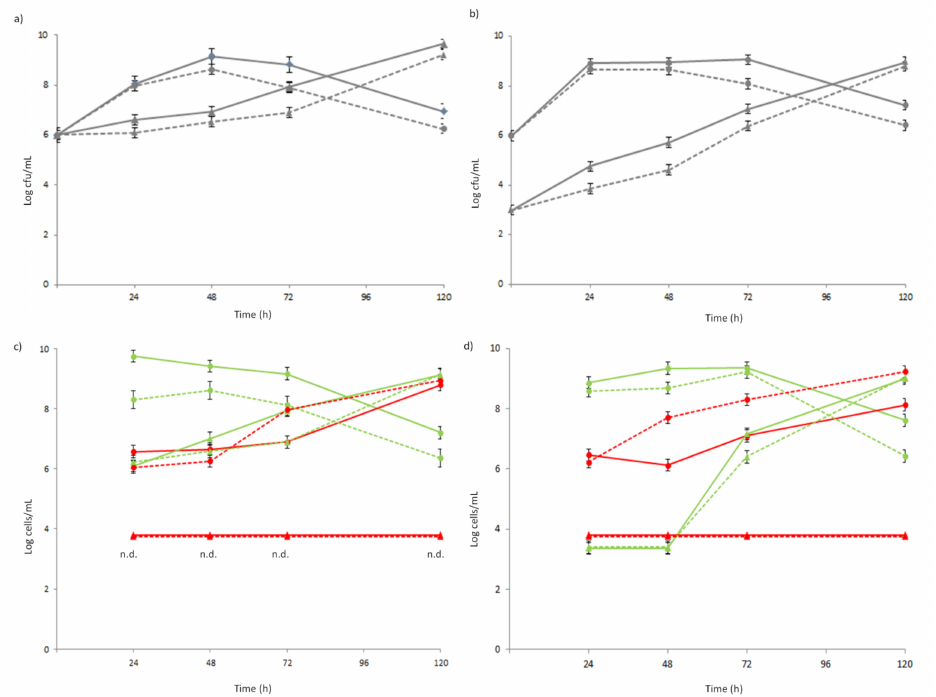
) and Lb. rhamnosus 1473 ( (cid:78) ) cultivated in co-culture for 120 h Figure 3. Enumeration of L. lactis 1426 ( • in the presence (dotted lines) and absence (solid line) of 0.30% A. platensis extract. Plate counts of co-culture 1 ( a ) and co-culture 2 ( b ). Fluorescent microscopic counts of co-culture 1 ( c ) and co-culture 2 ( d ): the number of viable cellsare in green and in red are the number of dead cells (n.d.: not detected; the cells’ concentration was under the 3 Log cells/mL).